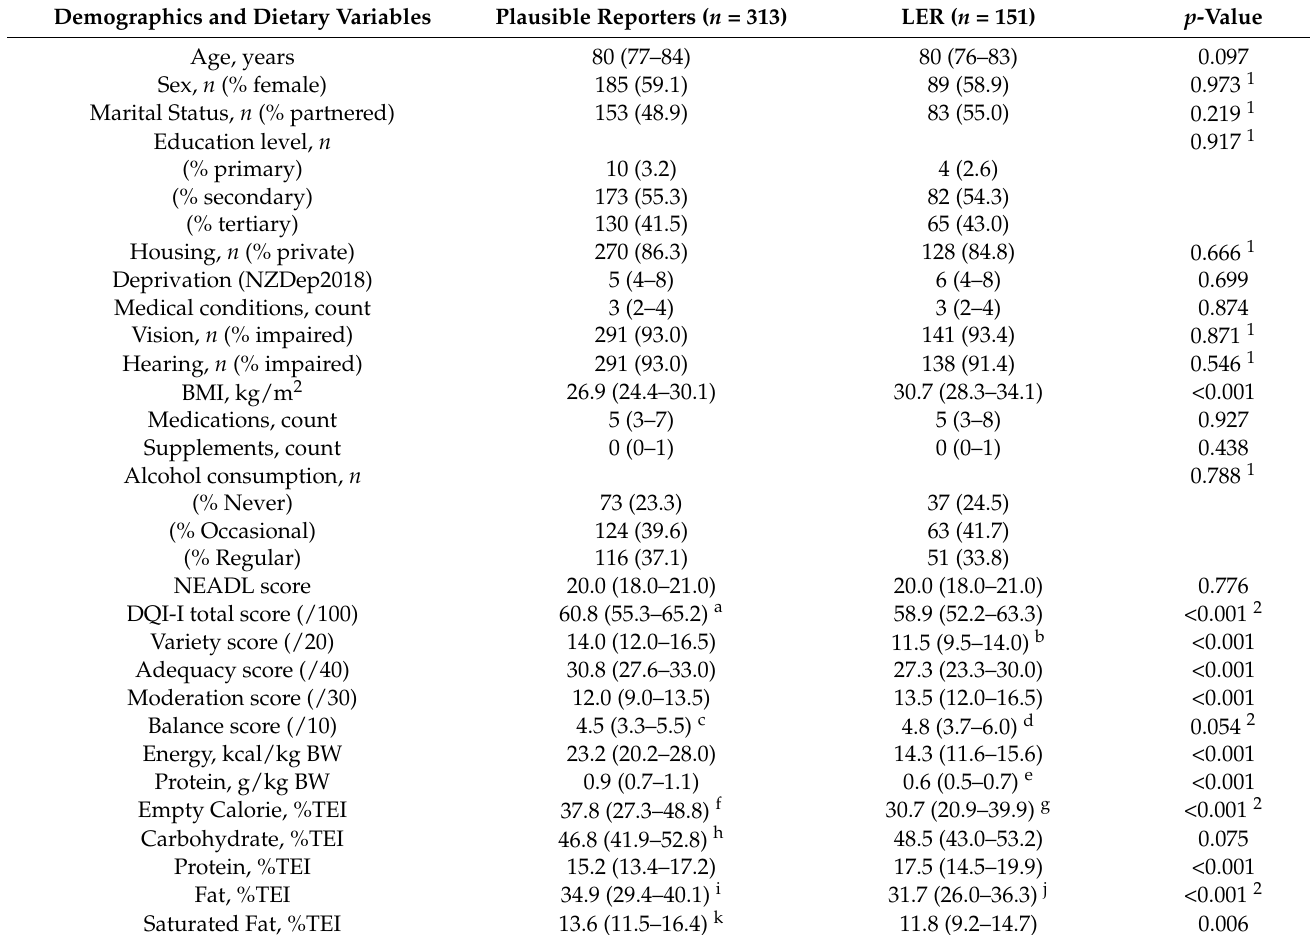
Table 2. Differences in demographics and diet quality between plausible reporters and LER. Demographics and Dietary